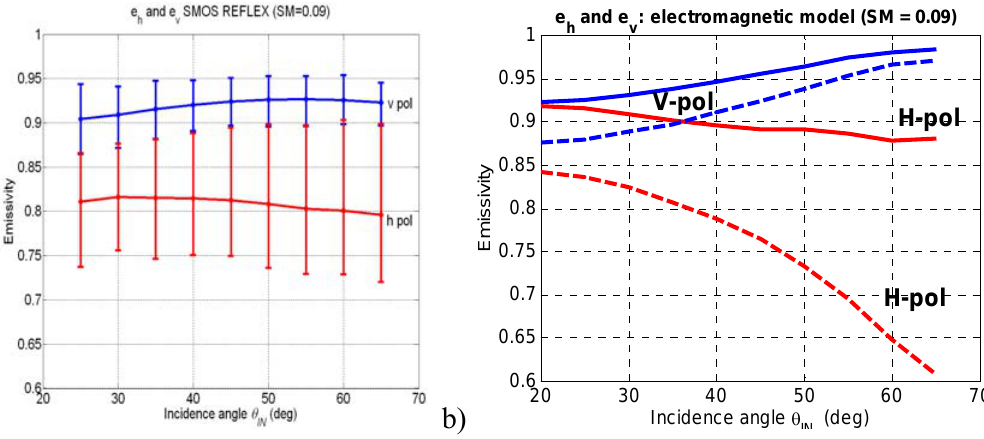
Figure 12. Emissivity at vertical and horizontal polarizations as a function of the incidence angle. a) Experimental data: mean value (solid line) and associated fluctuations due to different azimuth angles. b) Bare soil emission model from Section 2.2 (dashed line) and radiative transfer model computed from Equation (6) for soil and vines (solid